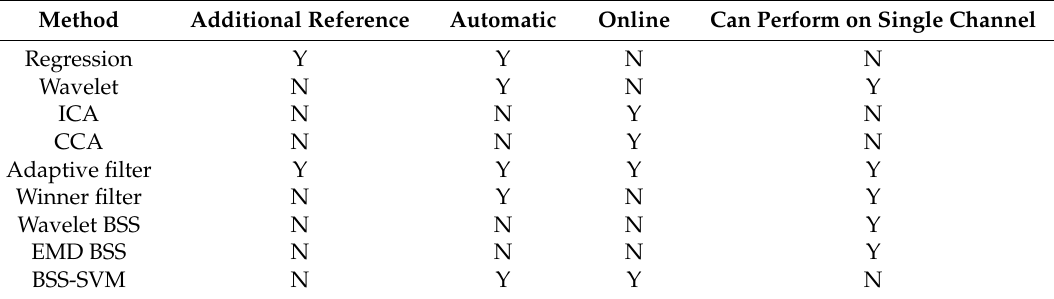
Table 2. Comparative analysis of methods mentioned